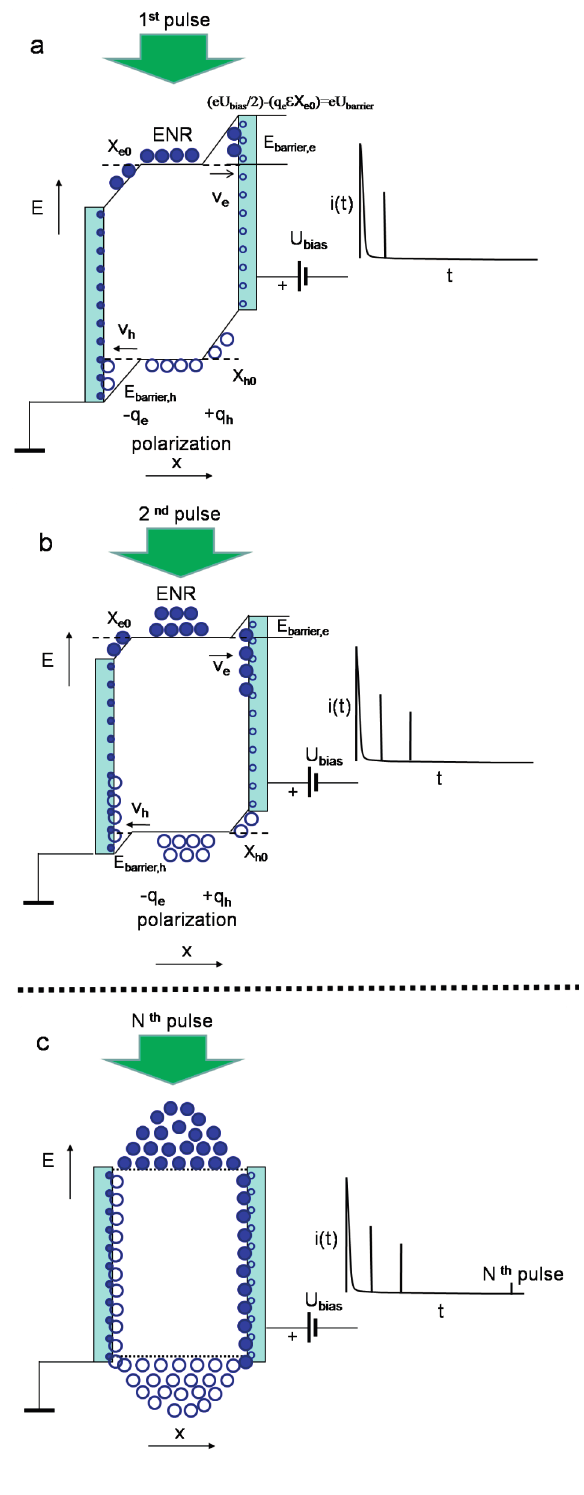
Figure 4. Sketches of evolution of the light injected charges (large circles) under switched-on external voltage of rather small value and of the dynamic polarization through accumulation of the space charge under a set of light pulses (1st— a , 2nd— b , and N -th— c ) those inject bulk density of excess carrier pairs (hollow and solid large circles). The dynamic depletion widths are denoted by X e0 and X h0 . The diagrams of the capacitor charging currents (vertical lines) after each N -th light pulse are there shown on the